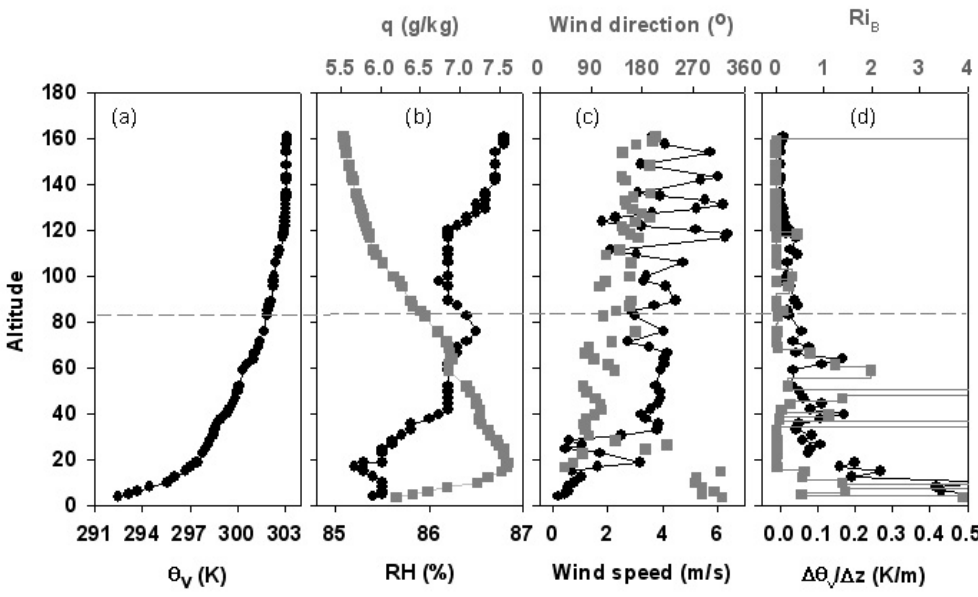
), (b) specific ( q ) and v and bulk v